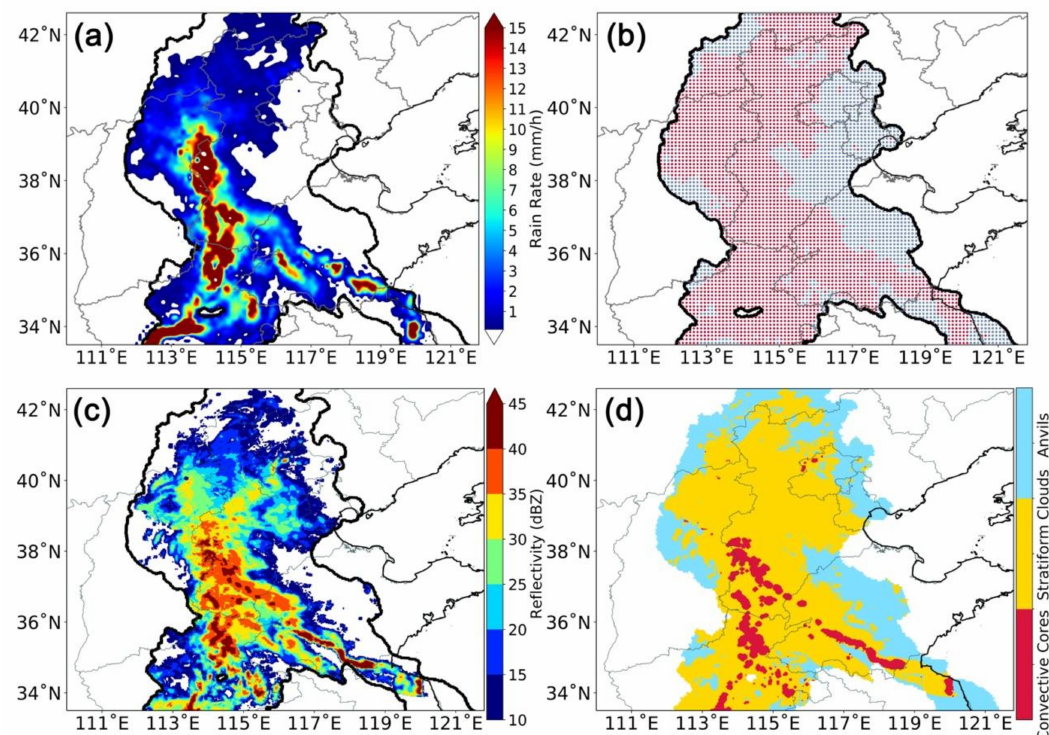
Figure 3. Schematic diagram showing how to quantify the precipitation and precipitation area produced by an MCS. The black line in each panel marks the extent of the MCS at 1100 UTC on 19 July 2016 over northern China, with cloud top brightness temperature (BT) less than 250 K. Inside the isotherm of 250 K, the rain rate is shaded by colors and superimposed on the map in panel ( a ), while in panel ( b ) the red solid (blue hollow) dots are those grid points with (without) precipitation reaching ground, with a rain rate higher than or equal to (less than) 0.1 mm / h. Panel ( c ) is same as ( a ), but shaded by radar reflectivity at 3 km above sea level, and panel ( d ) is shaded by di ff erent internal structures of an MCS as derived from reflectivity at 3 km above sea